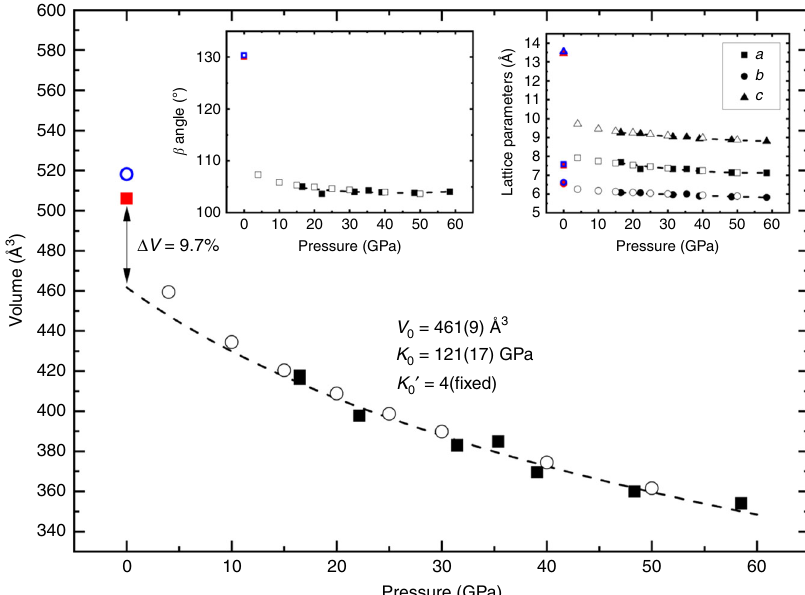
Fig. 3 Unit cell volume of the Mg 2 N 4 compounds as a function of pressure. All solid and open symbols are experimental and theoretical data points, respectively, while the dashed line is the fi t of the experimental PV data of the β -Mg 2 N 4 compound using the second order Birch-Murnaghan equation of state (BM2 EoS) ( V 0 = 461(9) Å 3 and K 0 = 121(17) GPa). Red and blue symbols are the experimental and theoretical, respectively, unit cell volume of α -Mg 2 N 4 at ambient pressure. The extrapolation of the experimental equation of state suggests a volume jump of 9.7% between the high pressure β -Mg α -Mg fi t of the theoretical PV data using the BM2 EoS gives for β -Mg V = 470.23 Å 3 and K = 2 N 4 and the ambient pressure 2 N 4 phases. The 2 N 4 0 0 110.83 GPa. The theoretical volume difference is thus of 10.2% between the calculated β -Mg 2 N 4 and α -Mg 2 N 4 . The insets show the dependence of the unit cell parameters on pressure. The full (open) black and full red (open blue) symbols represent experimental (theoretical) data from the β and α phases of Mg 2 N 4 . The slightly higher volume obtained from the DFT calculations, compared to the experimental values, shows the underbinding in GGA parameters (Fig. 3 and Supplementary Tables 5 – 8) vary smoothly below 18 GPa, the DACs were opened in a glovebox under with pressure, displaying no sign of a chemical reaction, an inert atmosphere of argon. After the release of pressure, the decomposition or phase transition down to 2.3 GPa. However, the DACs were closed, still in the glovebox, so that the samples were opening of the DACs in air leads to the loss of the Raman signal preserved in an inert atmosphere at ambient pressure. Micro- from the sample, caused by its deterioration, presumably fol- photographs of a sample before and after the complete release of lowing a chemical reaction with the water or the oxygen in air pressure are shown in Supplementary Fig. 12. The Raman spectra (see Supplementary Fig. 13). Therefore, at various pressures of these decompressed samples appeared to be different from